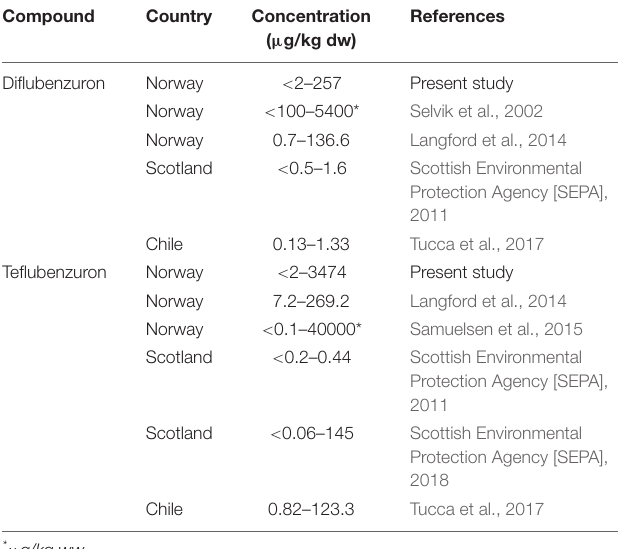
TABLE 2 | Comparative ranges of anti-parasitic pesticide levels in marine sediments from other areas of the world with intensive salmon aquaculture activities.